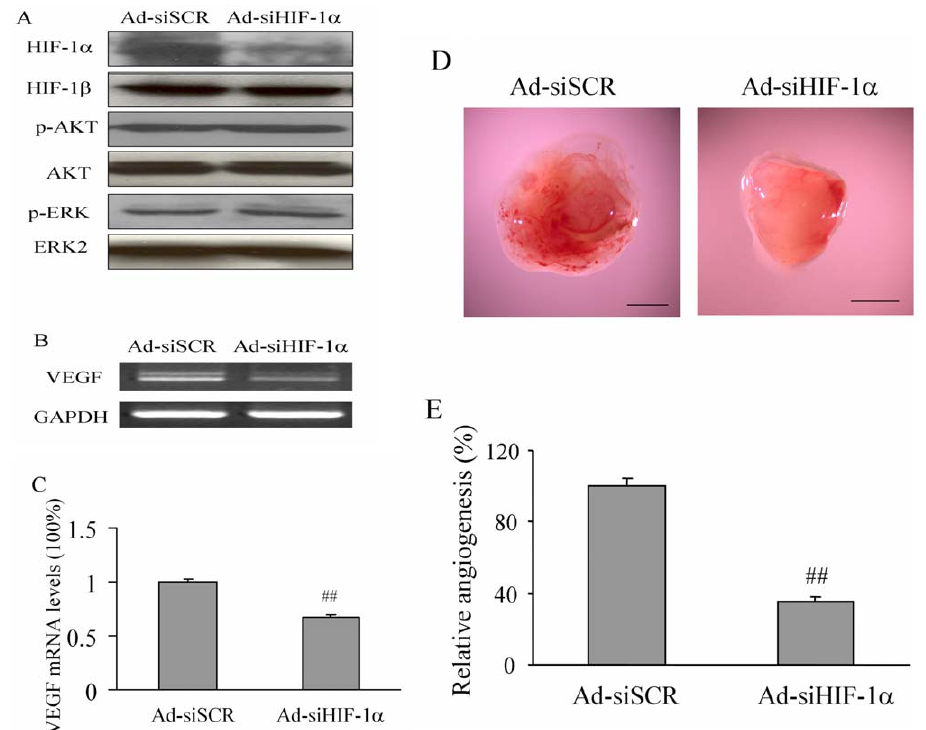
Figure 6. HIF-1 a expression is required in miR-21 inducing VEGF expression and tumor angiogenesis. (A) DU145 cells were transfected with pre-miR-21. After 24 h incubation, cells were infected with adenovirus carrying GFP (Ad-SCR) or siRNA against HIF-1 a (Ad-siHIF-1 a ) at 20 MOI for 24 h. The total proteins were analyzed by immunoblotting. (B–C) The expression levels of VEGF and GAPDH mRNA were analyzed by RT-PCR (B), and by real-time RT-PCR (C). (D) After DU145 cells were transfected with pre-miR-21 for 24 h, the cells were infected with Ad-GFP or Ad-siHIF-1 a at 20 MOI for 24 h. Then the cells were used to perform angiogenesis assay as described above. The picture showed the representative plugs from Ad-GFP and Ad-siHIF-1 a treatment groups. Scale , 2 mm. (E) The number of blood vessels were counted from replicate experiments, and normalized to that of the Ad-siSCR group as relative angiogenesis. The data are mean 6 SD from 6 replicate experiments. ## , indicates the significant difference when compared to that of the Ad-siSCR group ( p ,